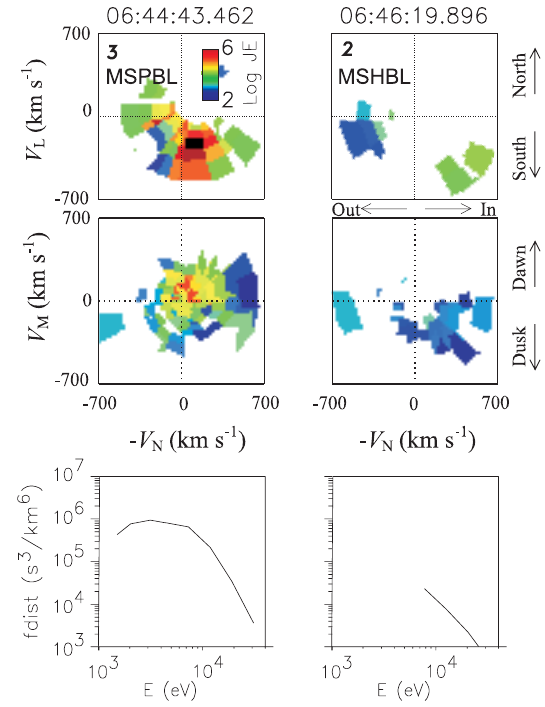
Fig. 4. From top to bottom, cutaway of the O + distribution function in the ( N , L ) plane at V M = <V M > in Log[eV/(scm 2 sreV)], in the ( N , M ) plane at V L = <V L > in Log[eV/(scm 2 sreV)], and solid- angle averaged distribution function in s 3 km − 6 versus energy. The number in the topleft-hand side corner of each velocity distribution plot in the ( N , L ) plane refers to the region, according to Fig. 3.